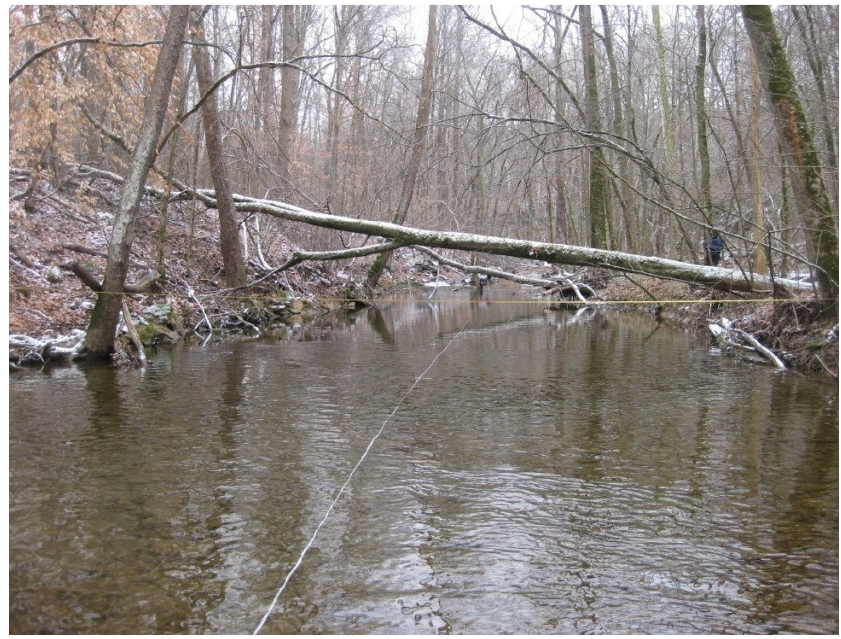
Figure 2. Example of forest-dominated riparian vegetation at Little Goose near Harrods Creek (03292480) in the Outer Bluegrass